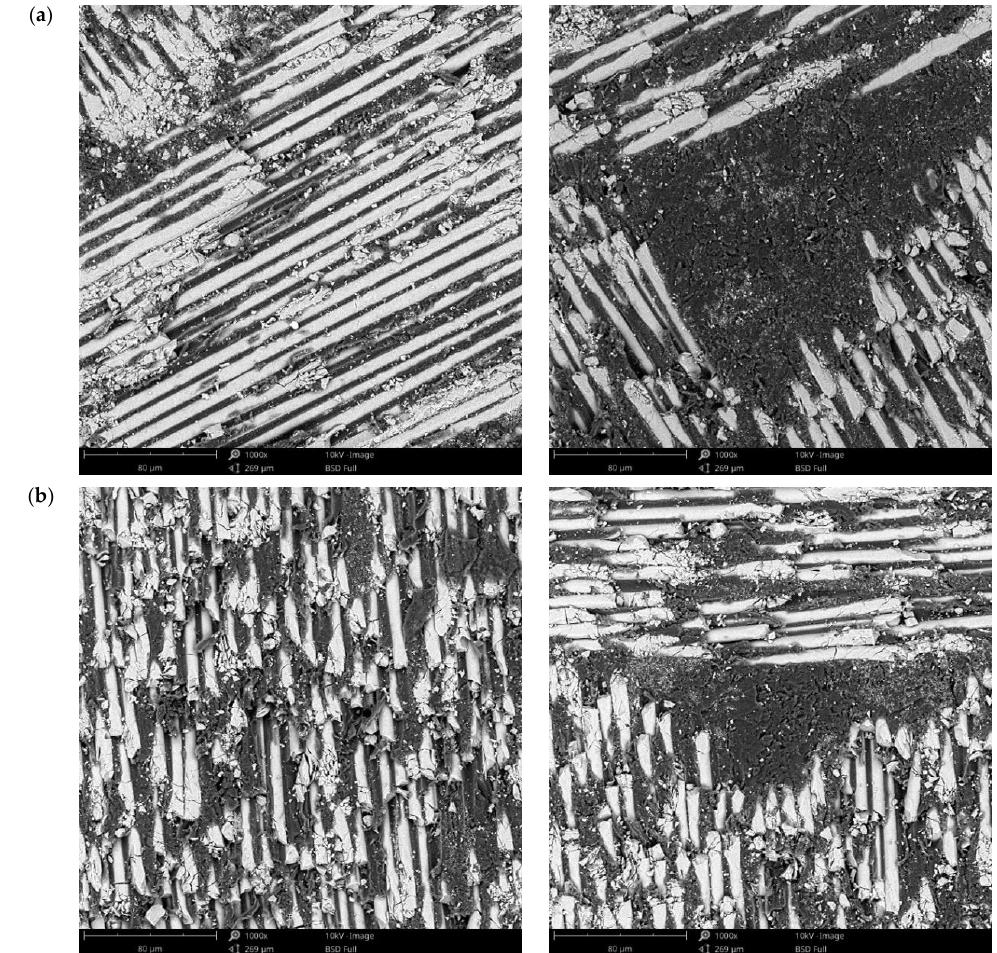
pH 5.7 (1000×). artificial saliva with pH 5.7 (1000 × ).